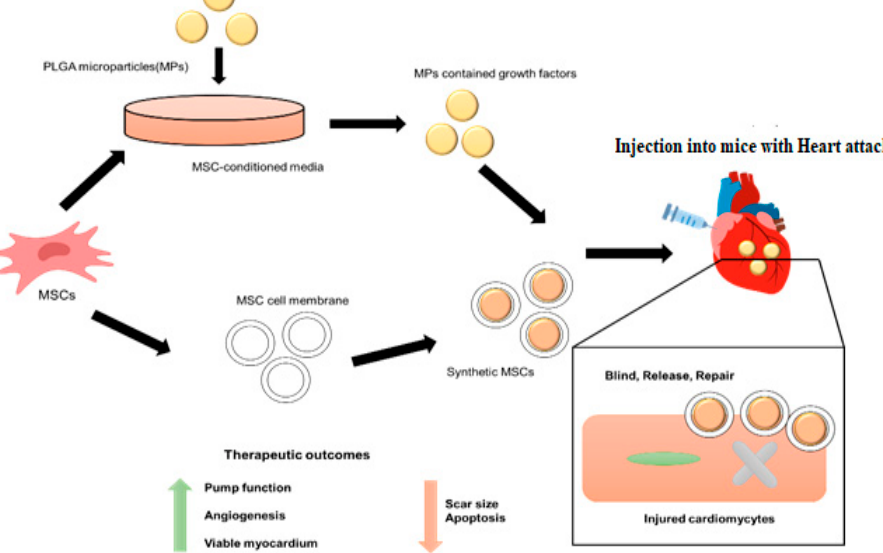
Figure 6. To encourage tissue recovery through cell proliferation, remuscularization, and angiogen- esis, synthetic MSCs release growth factors that have been loaded.